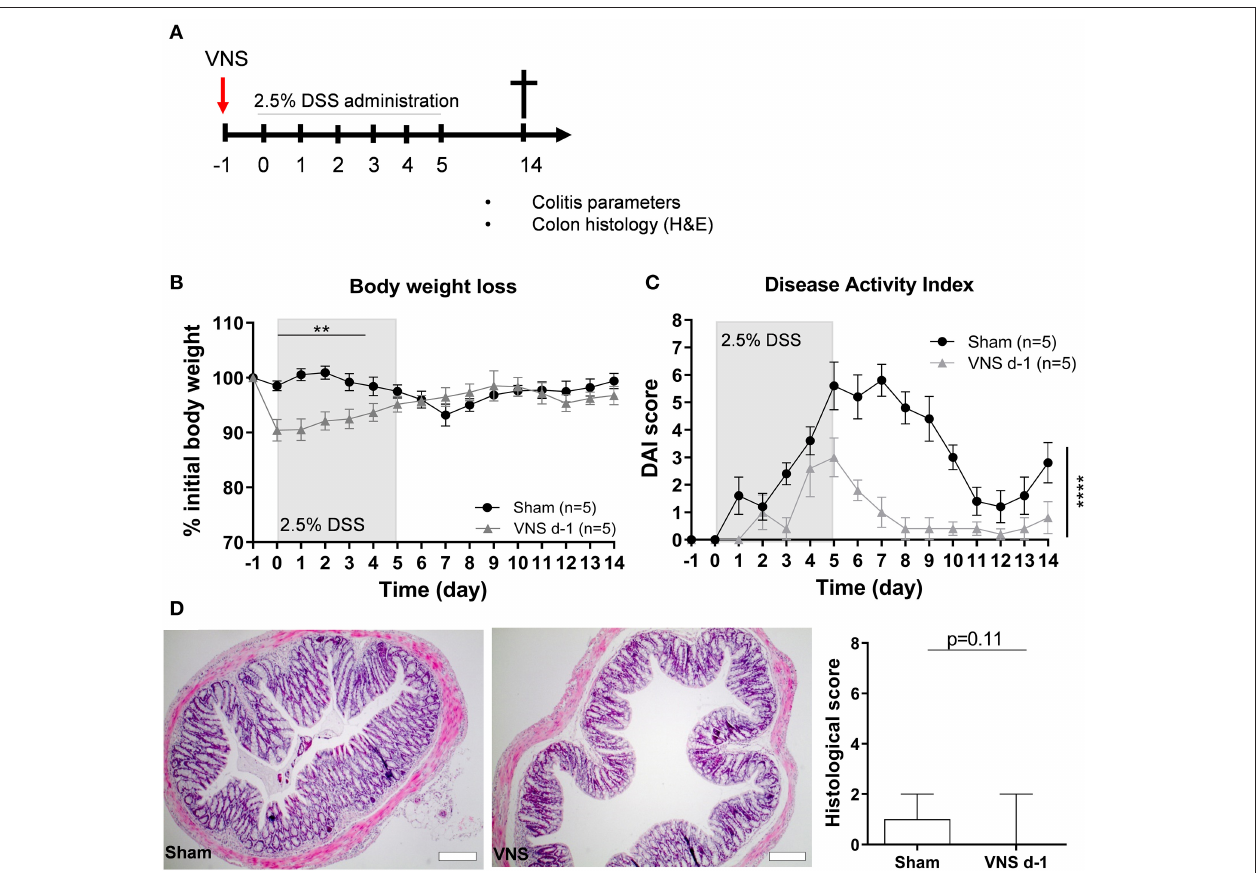
FIGURE 1 | Vagus nerve stimulation prior to DSS exposure improves colitis. (A) Wild type mice were stimulated at day − 1 and exposed to 2.5% DSS in the drinking water for 5 days, colitis severity was assessed daily. Mice were sacrificed at day 14 and tissue samples were collected for different analysis. Body weight (B) and disease activity index (C) were assessed daily. (B,C) Data are expressed as mean ± SEM as determined by the repeated-measures two-way ANOVA test. ** p < 0.01; **** p < 0.0001; ( n = 5 mice per group) (D) Representative H&E stainings of colonic sections from control sham- and VNS-stimulated mice. Scale bars are 200 µ m. Bar graphs represent histological injury score of colonic samples of sham- and VNS-treated mice 14 days post colitis induction. Data are expressed as median ± interquartile range as determined by the Mann- Whitney test ( n = 5–6 mice per group). (A–D) shows representative experiment with at least 1 similar